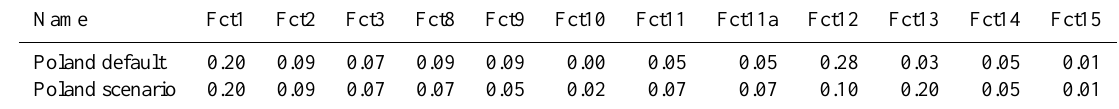
Table 3. Relative distribution of the total NH 3 emission from the agricultural activities in Poland as defined by Fct 1 –Fct 15 . Poland default – distribution based on Europe-wide default settings, Poland scenario – distribution based on Polish practice and regulations. Name Fct1 Fct2 Fct3 Fct8 Fct9 Fct10 Fct11 Fct11a Fct12 Fct13 Fct14 Fct15 Poland default 0.20 0.09 Poland scenario